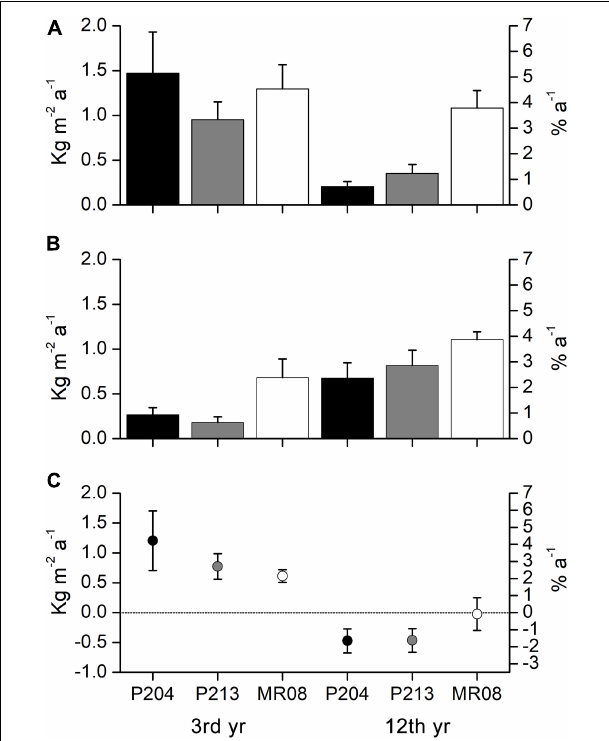
FIGURE 4 | Mean ( ± s.e.) annual bioconstruction (A) and bioerosion (B) rates (kg m − 2 a − 1 and % a − 1 ), and annual bioconstruction-bioerosion net balance (C) (kg m − 2 a − 1 and % a − 1 ) measured on the experimental tiles for each site after 3 and 12 years of exposure (dashed line marks zero net balance). Percentage axes represent the relative contribution to the annual bioconstruction and bioerosion rate and net balance, in volume, compared to the initial size of the experimental